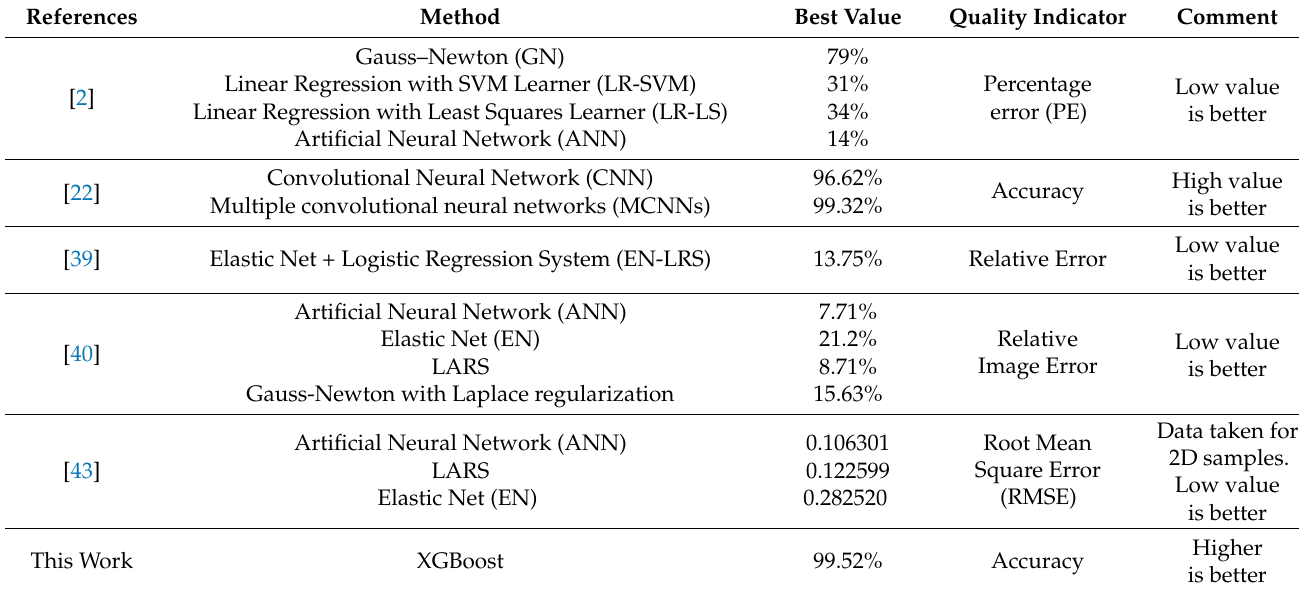
Table 1. Comparison of the results obtained with different